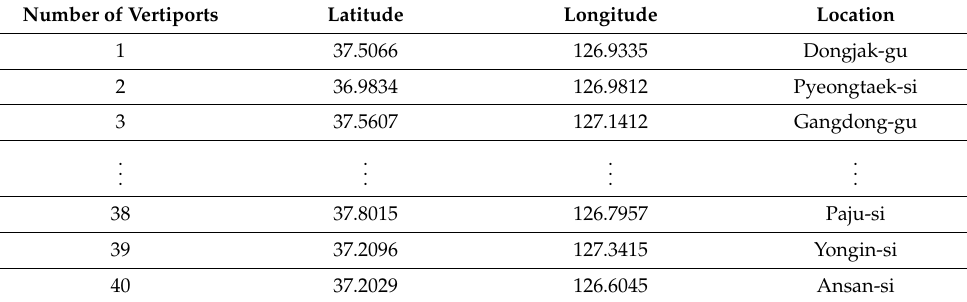
Table 3. Location of vertiports when the number of vertiports is 40.